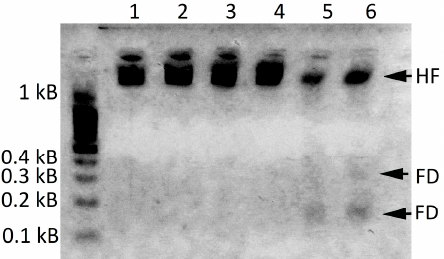
Figure 6. Electrophoretic separation of DNA extracted from tissues of live LdMNPV-infected gypsy moth larvae (1% agarose gels). The positions of DNA markers are indicated on the left. Lanes: 1,2—water control; 3,4—oligoCpG treatment; 5,6—oligoRING treatment. Signs: FD—apoptotic fragmented DNA (around 180 and 360 bp); HF—higher fraction of undergraded genomic DNA. Data in each agarose lane represent DNA from three live larvae from every group in the experiment.